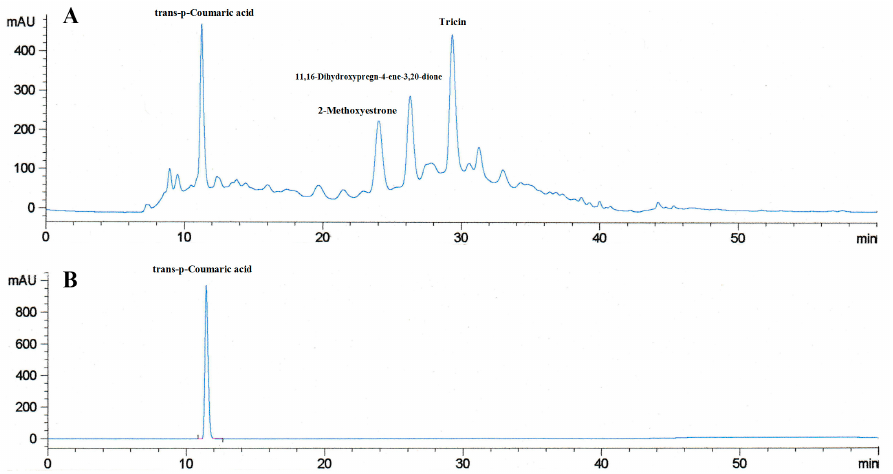
Figure 2. HPLC-DAD chromatogram of IMP aerial part ethyl acetate extract at 323 nm. IMP aerial part ethyl acetate extract solution (10 mg/mL in methanol, 20 µ L) was analyzed in the 60 min HPLC gradient program. ( A ) The retention time of the trans-p-Coumaric acid standard (0.125 mg/mL in methanol, 20 µ L) purchased from Sigma ( B ) was consistent with compound ( 1 ) in IMP aerial part ethyl acetate extract